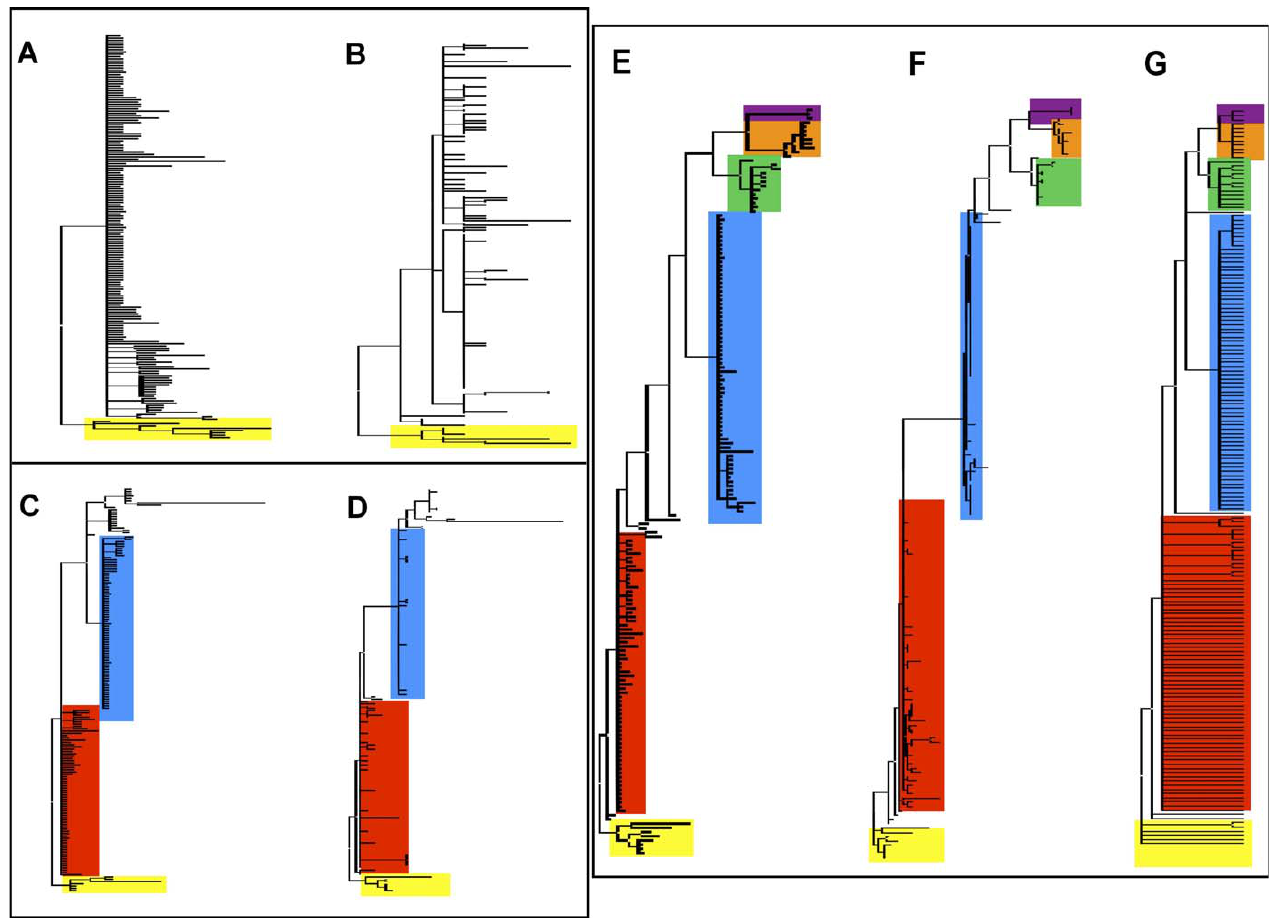
Figure 3. Phylogenic Reconstruction of the GII.4 Shell Domain and P1 and P2 Subdomains Independent multiple alignments were generated using 176 amino acid sequences divided into the S, P1, and P2 regions of the capsid, and trees were generated for each alignment using three different methods, with clusters marked as follows: yellow, sequences from Camberwell cluster; red, sequences from Grimsby cluster; blue, sequences from the Farmington Hills cluster; green, sequences from the Hunter cluster; orange, sequences from the Sakai cluster; and purple, sequences from the Den Haag cluster. Unmarked branches represent sequences that did not group with any specific cluster. The trees are drawn to similar scales and are rooted with the earliest Camberwell cluster. (A) BI of the S domain predicts only two distinct clusters with Camberwell as the first, while everything else groups into a single large cluster (for full tree see Figure S5). (B) The MEGA 4.0 MP tree of the S predicted similar results as the Bayesian tree, although there are two nondistinct clusters arising from the LCA derived from the Camberwell cluster (for full tree see Figure S6). A MP tree generated by PAUP 4.0b10 predicted similar results (Figure S7). (C) BI of the P1 domain predicted that the Camberwell cluster gave rise to the Grimsby cluster from which the Farmington Hills and all later clusters emerged, although the extant clusters were not fully resolved (for full tree see Figure S8). (D) The MEGA 4.0 MP tree of P1 predicted similar results, although it showed that Grimsby gave rise to the Farmington Hills cluster, from which the later clusters emerged. However, the Den Haag cluster falls within the Farmington Hills cluster (for full tree see Figure S9). An MP tree generated by PAUP 4.0b10 predicted similar results (Figure S10). (E) BI of the P2 subdomain predicts that Camberwell gave rise to Grimsby, which in turn gave rise to LCAs from which Farmington Hills and the three extant clusters evolved independently. All six clusters are distinct (for full tree see Figure S11). (F) The MEGA 4.0 MP bootstrapped tree agreed with the Bayesian tree (for full tree see Figure S12). (G) The MP bootstrapped tree generated using PAUP 4.0b10 predicted a nearly identical tree as the Bayesian tree (for full tree see Figure S13). The fact that all three methods generated similar trees with distinct clusters suggests that the P2 subdomain is the most appropriate region with which to determine phylogeny for the GII.4